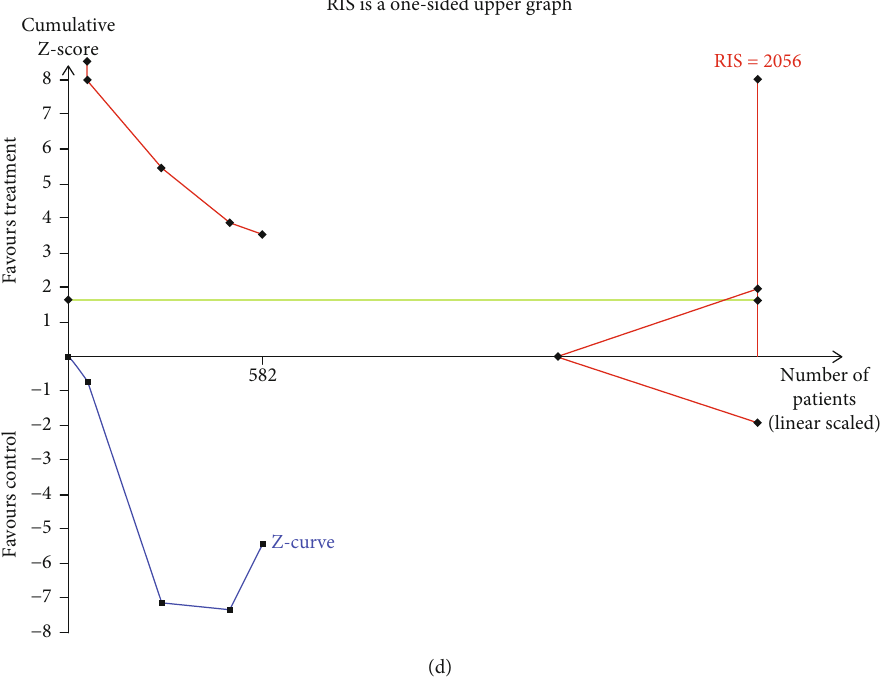
Figure 5: (a) Forest plots of the e ff ect of oral iron on 6 MWT; (b) subgroup analysis of treatment frequency on 6 MWT; (c) subgroup analysis of treatment duration on 6 MWT; (d) trial sequential analysis of 6